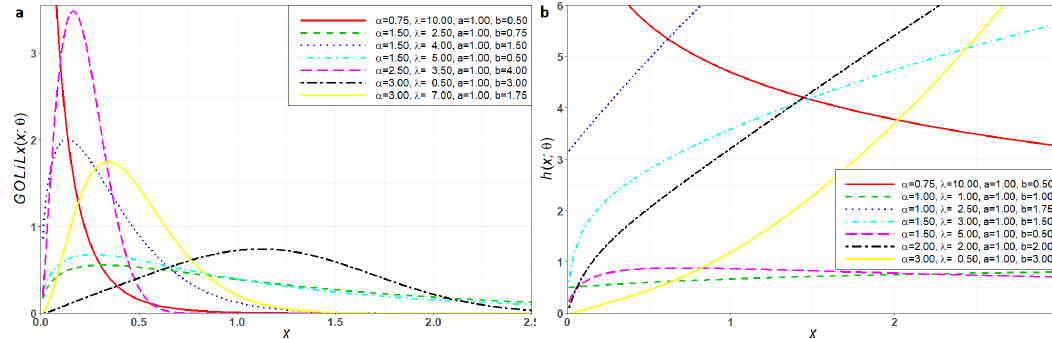
Figure 3 - Plots of the GOLiLx pdf ( a ) and hrf ( b ) for some parameter